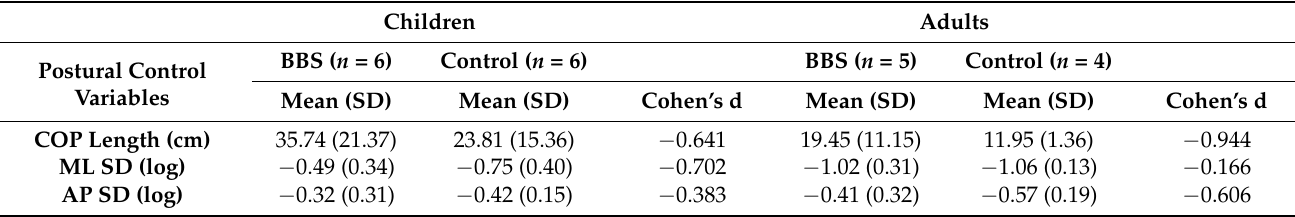
Table 3. Group comparisons of postural ability in children and adults with 15q11.2 BP1-BP2 deletion syndrome and matched controls. Children Adults Postural